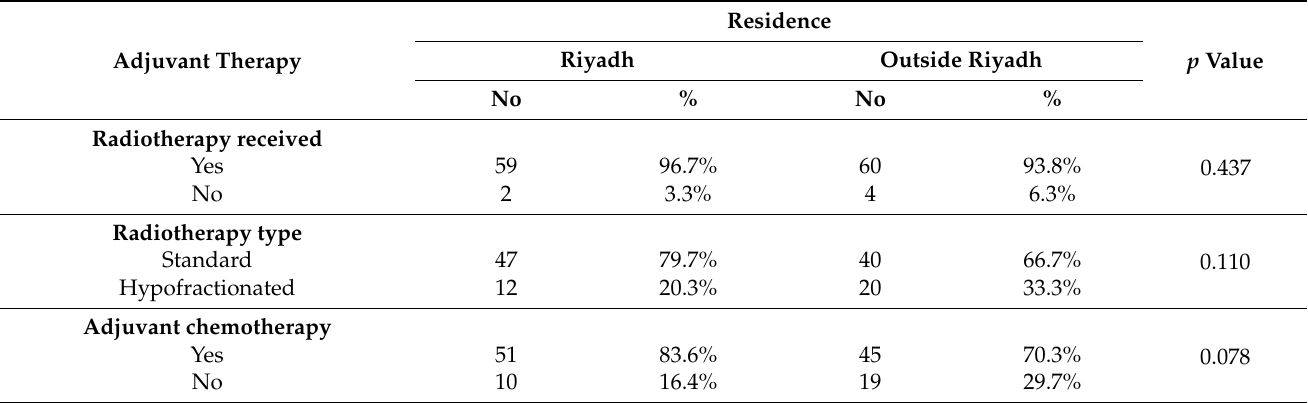
Table 4. Distribution of adjuvant therapy to patients with GBM, by residence.